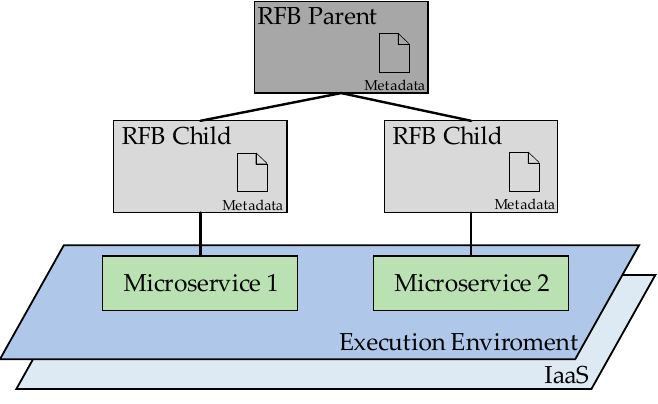
Figure 2. The concept of Reusable Functional Blocks.